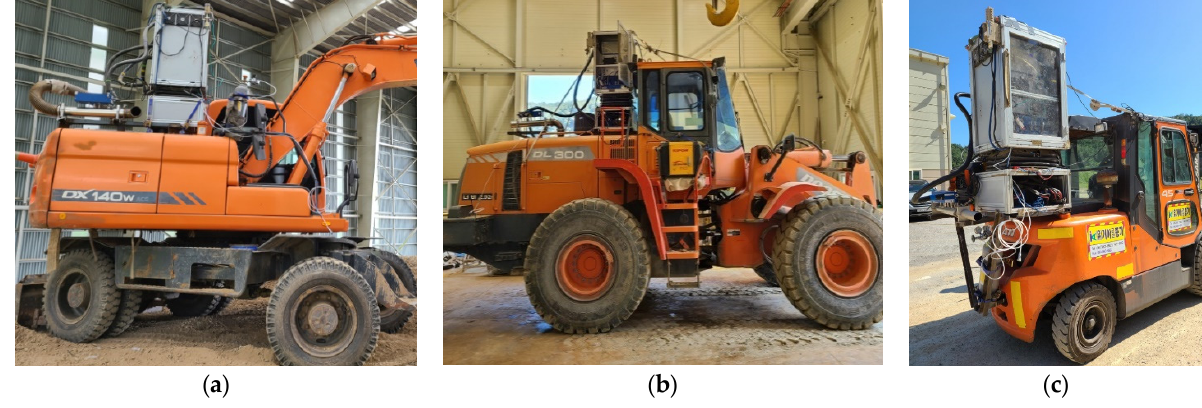
Figure 1. Real-operation of construction machinery with PEMS; ( a ) Excavator, ( b ) Wheel loader, ( c ) Fork-lift. Table 3. Specification of the PEMS (Semtech Ds